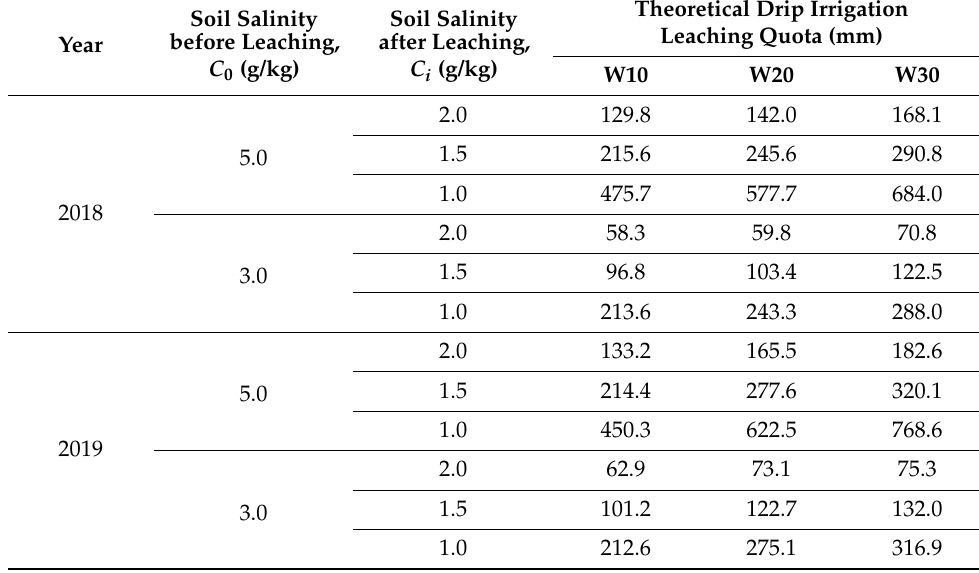
Table 5. Theoretical drip irrigation leaching quota under different scenarios. Soil Salinity before Year